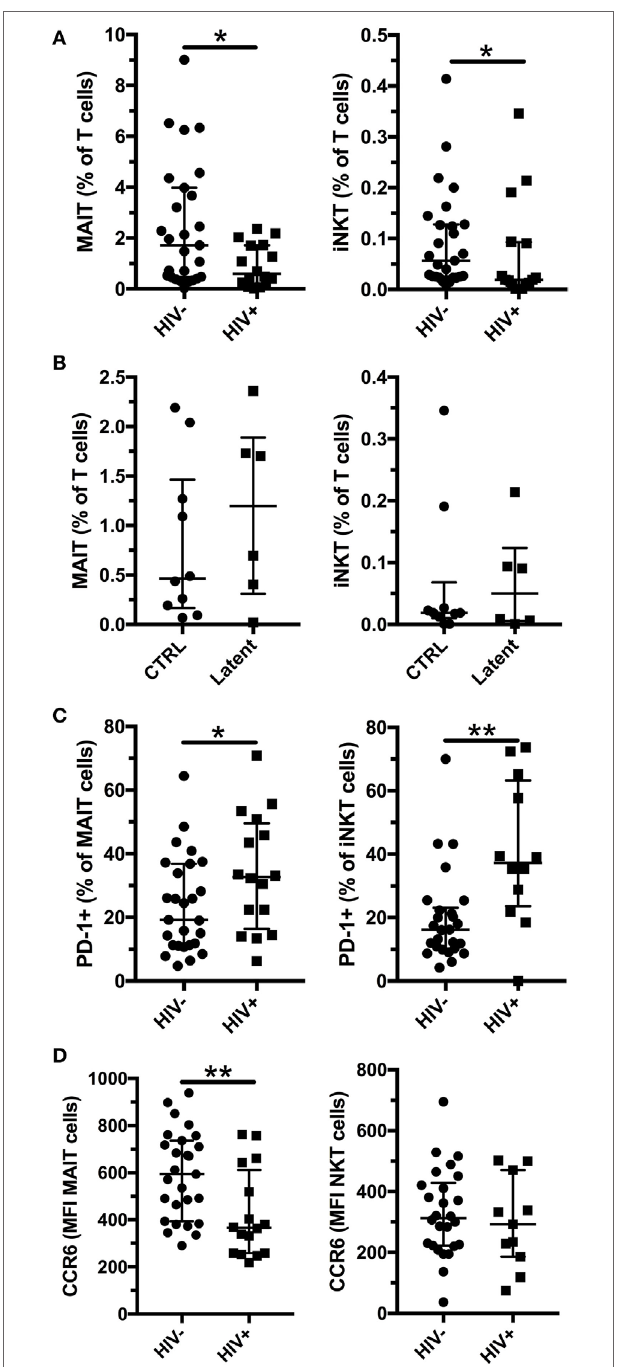
FigUre 4 | Mucosal-associated invariant T (MAIT) and invariant natural killer T (iNKT) cells are reduced in HIV-1 infection. Frequency of MAIT (left panel) and iNKT (right panel) cells in HIV-1-uninfected ( n = 27) and infected ( n = 16) subjects without active Mycobacterium tuberculosis (Mtb) infection (a) . Frequency of MAIT (left panel) and iNKT (right panel) cells in Mtb uninfected ( n = 10) and with latent Mtb infection ( n = 6) HIV-1-infected subjects (b) . PD-1 expression (c) and CCR6 expression (D) by MAIT (left panel) and iNKT (right panel) in HIV-1-uninfected ( n = 27) and -infected ( n = 16) subjects without active Mtb infection. The lines and whiskers represent the median and interquartile range, respectively (* p < 0.05 and ** p <